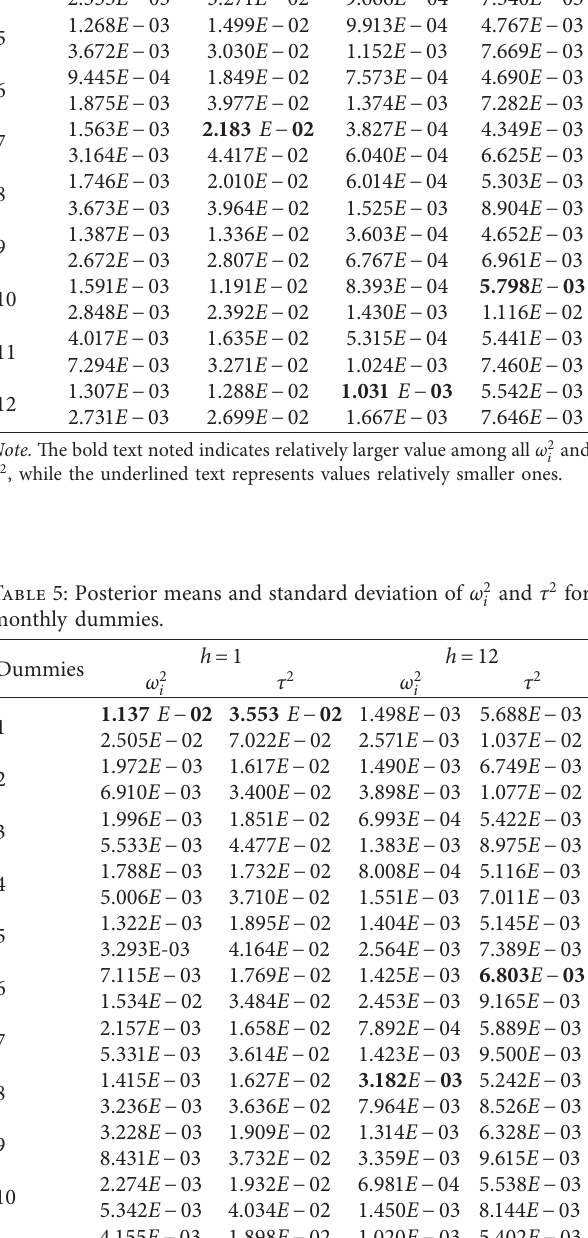
Table 4: Posterior means and standard deviation of ω 2 lags.